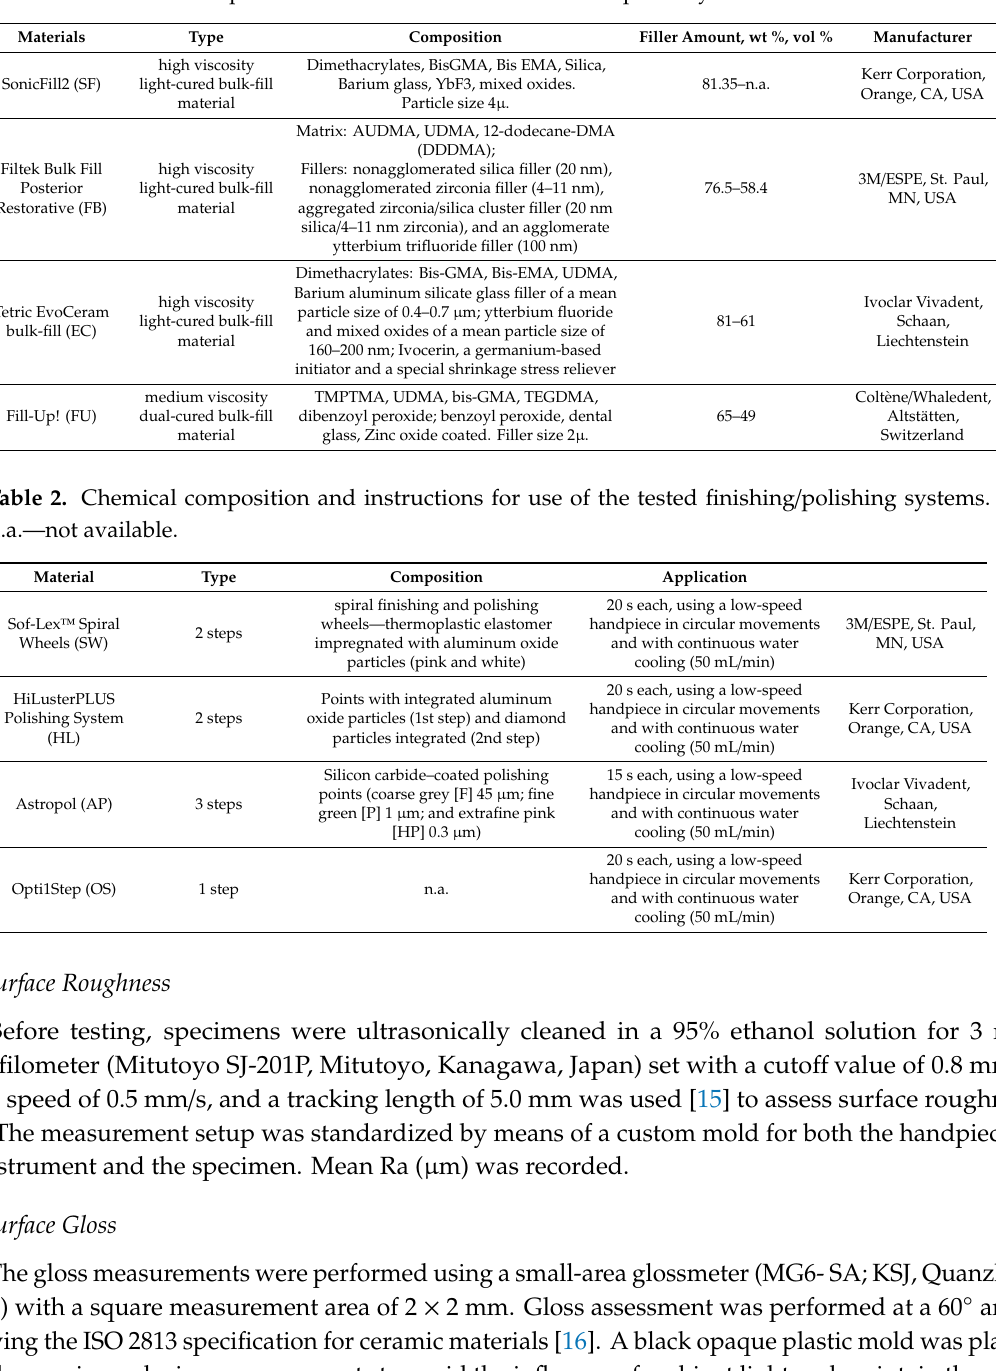
Table 1. Chemical composition of the tested bulk-fill resin composite systems. n.a.—not available.